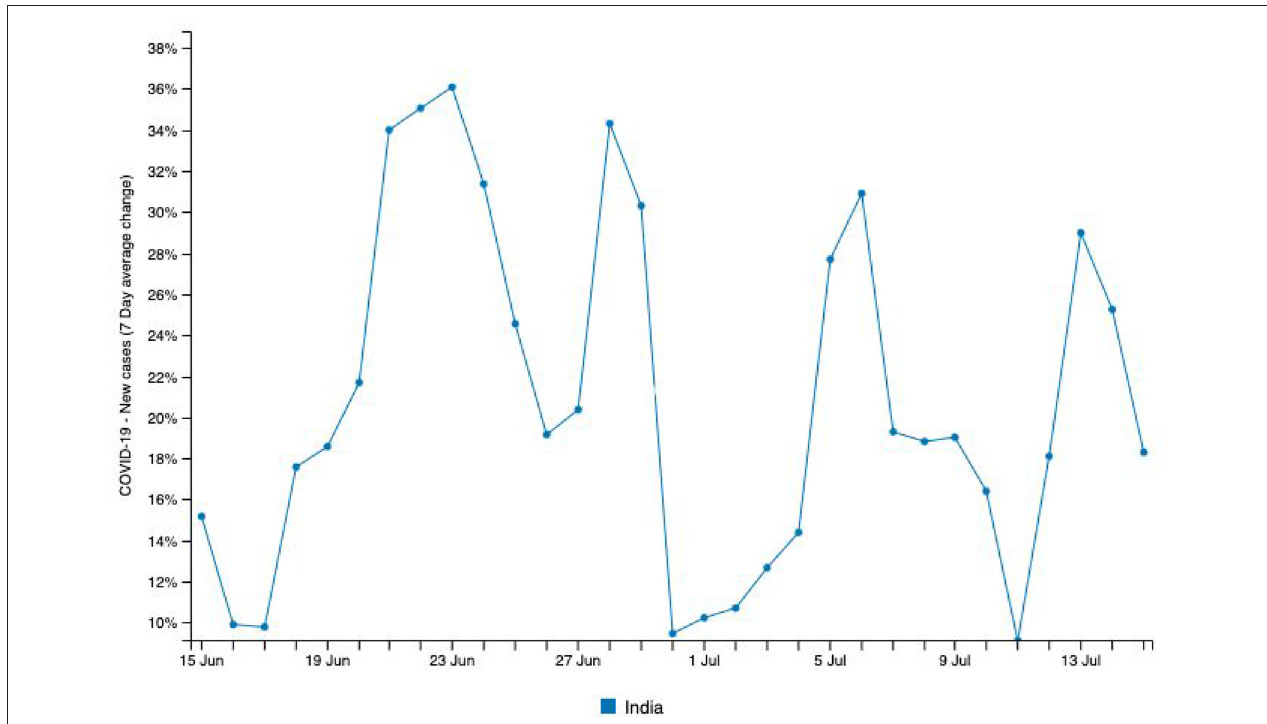
FIGURE 2 | Source: http://www.smaartrapidtracker.org, accessed on July 27, 2020. The New cases (7 Day average change) of COVID-19 in India (June15, 2020, to July 15th, 2020).